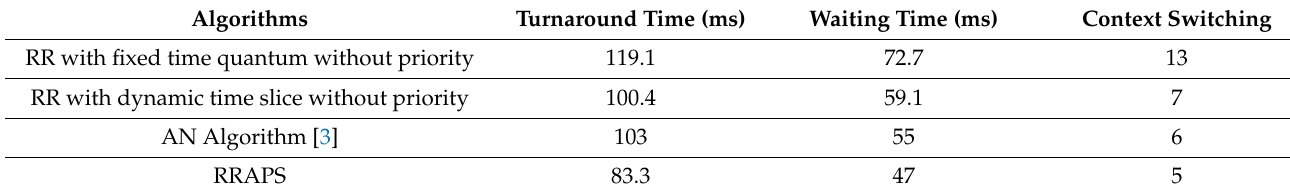
Table 3. The outcome of Case 3 among alternative algorithm techniques.